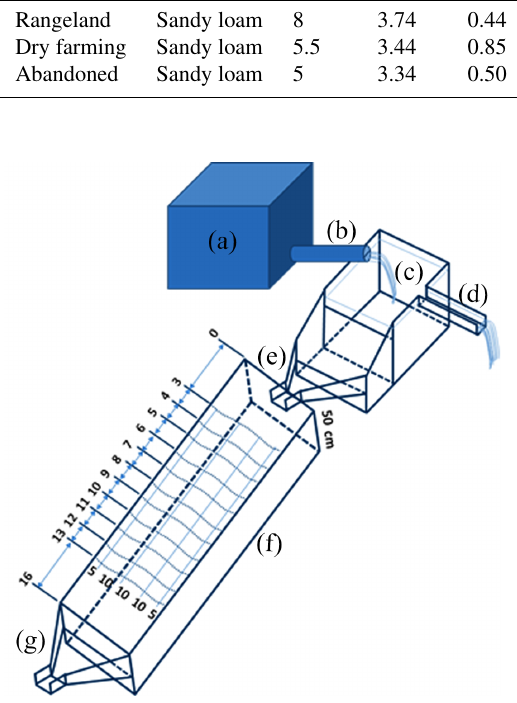
Figure 2. Schematic of experimental flume. (a) Main water supply; (b) input of stilling pond; (c) small retention pond; (d) overflow spillway for constant levelling; (e) inlet Parshall flume; (f) mid- section mesh used to measure flow depth and ground elevation; (g) outlet Parshall